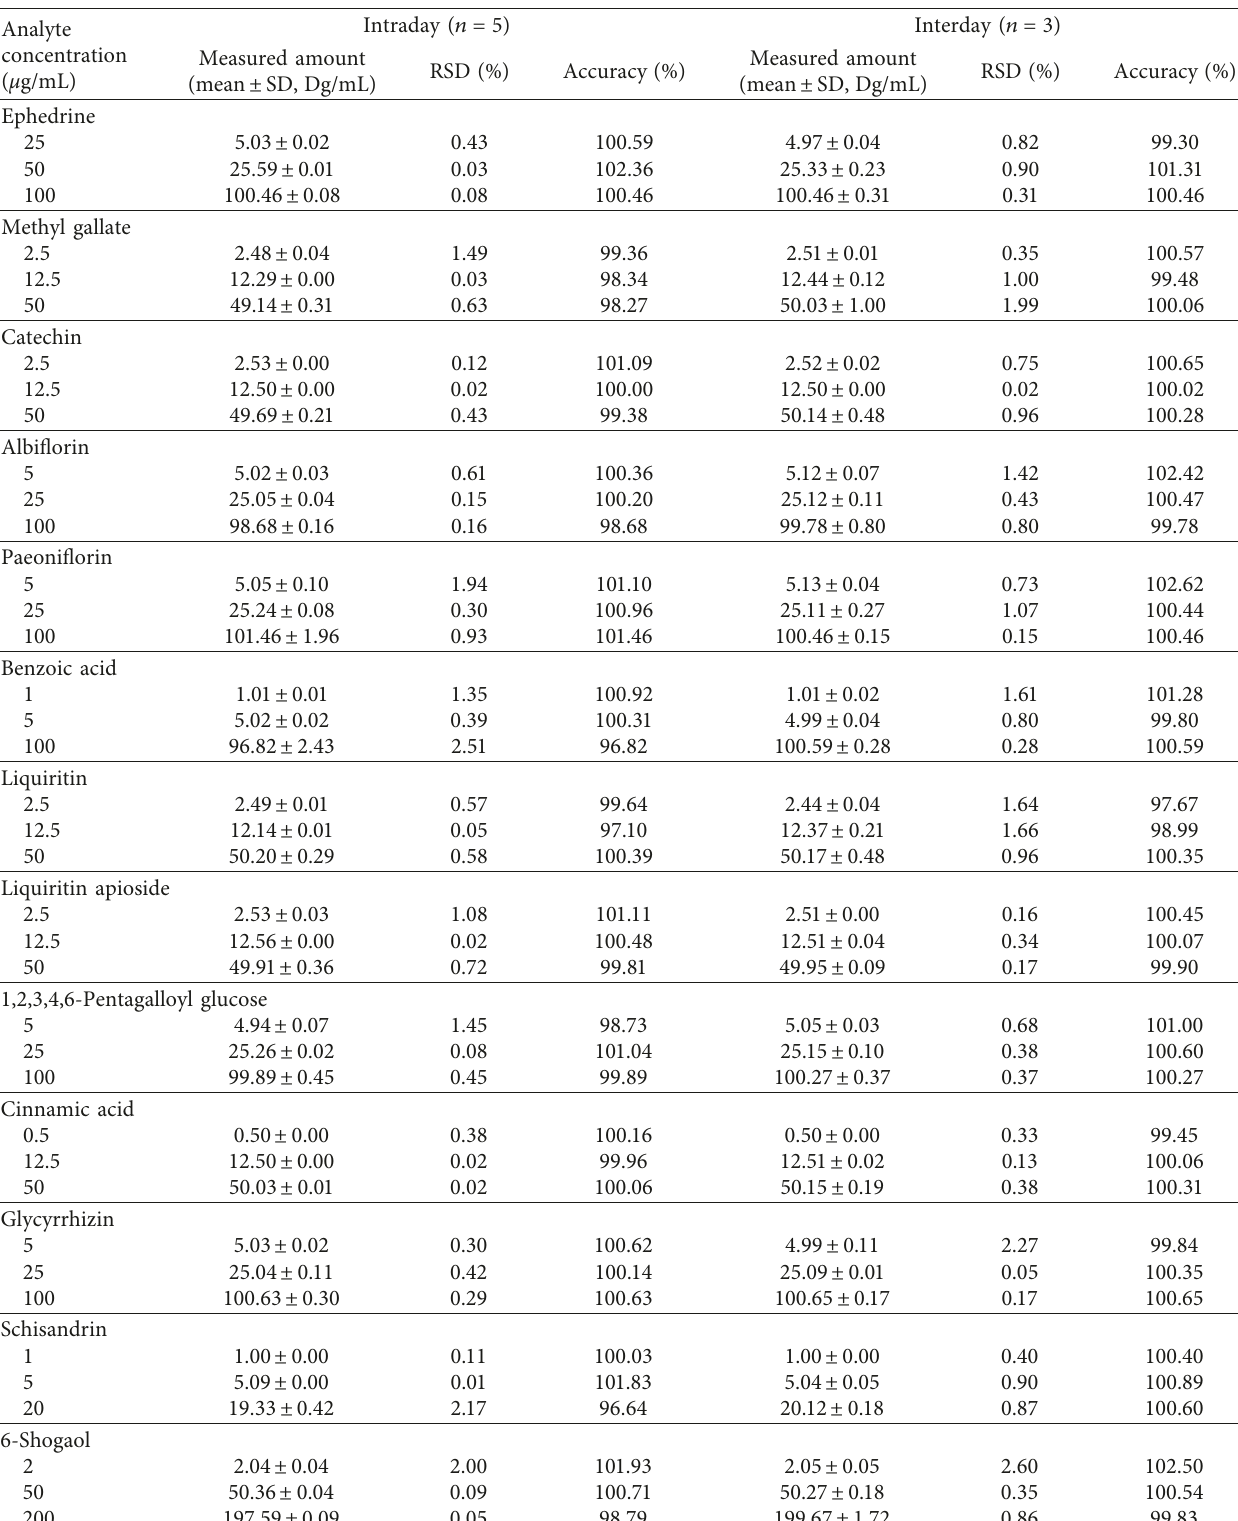
Table 2: Precision (intra- and interday) and accuracy of the thirteen analytes.